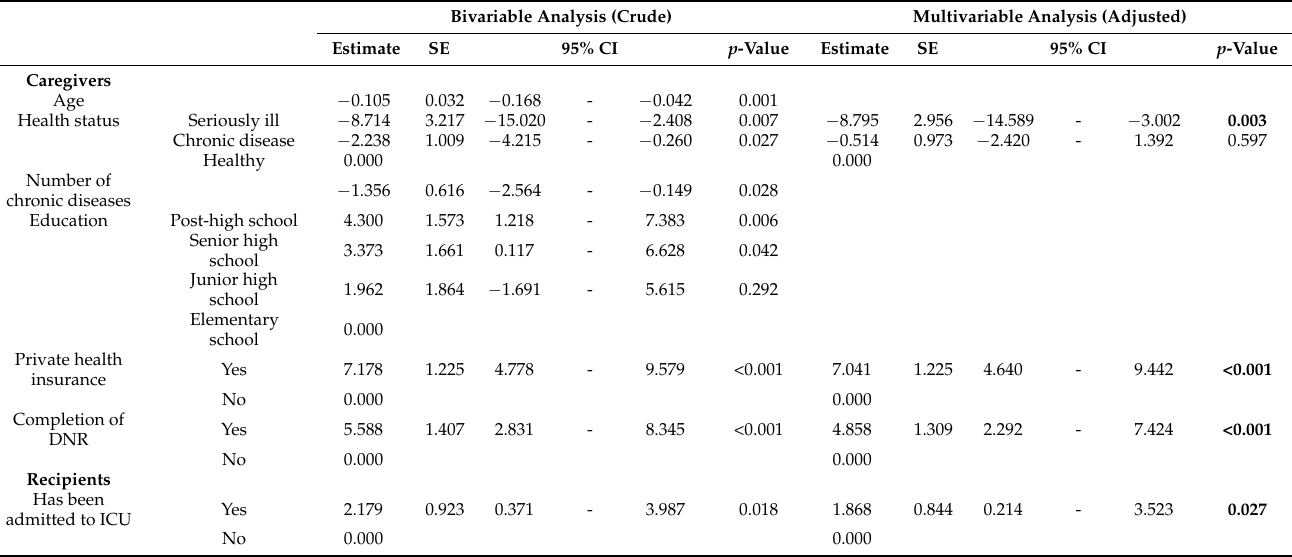
Table 4. The results of generalized linear models on the attitude towards ACP. Bivariable Analysis (Crude) Multivariable Analysis